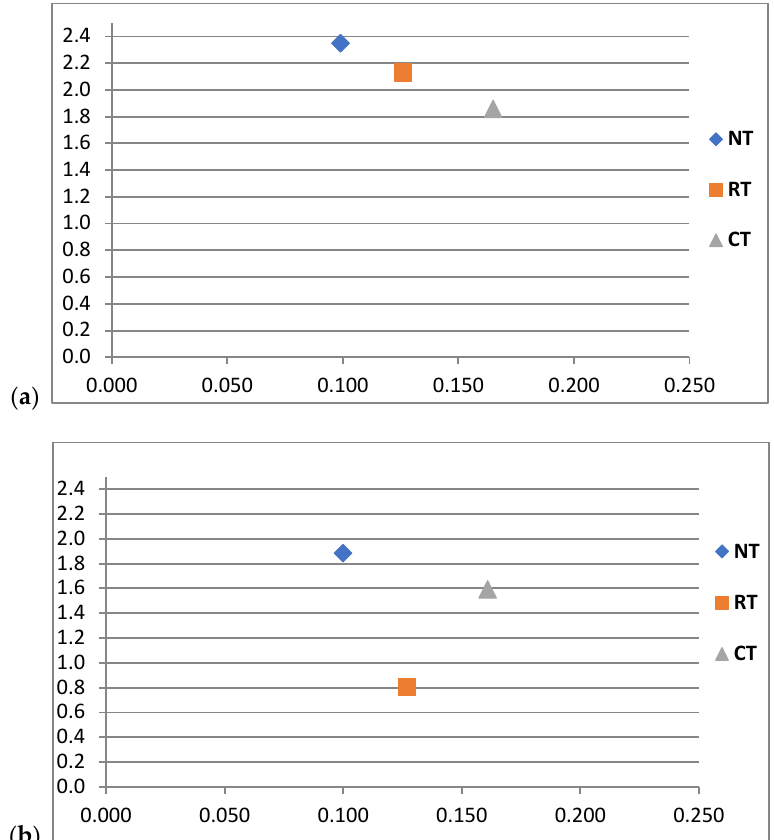
Figure 4. Shannon–Wiener’s diversity index ( H’ ) and Simpson’s dominance index ( SI ) of the weed community in ( a ) pea, ( b ) lupine crop in flowering stage depending on the tillage system (mean for 2017–2019). NT—no-tillage, RT—reduced tillage, CT—conventional tillage.